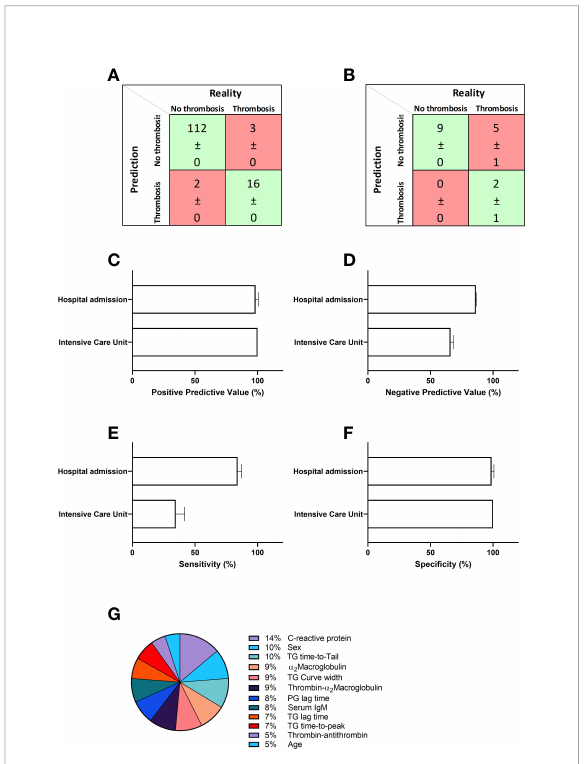
FIGURE 2 Prediction of thrombosis in hospitalized COVID-19 patients. A neural network was constructed to predict thrombosis based on the input parameters described in table 2 in the fi rst patient cohort. (A) The confusion matrix shows that on average 112 out of 114 non- thrombosis patients were correctly predicted and 16 out of 19 were correctly predicted to suffer from thrombosis due to COVID-19. (B) Further validation of the network in a second and separate cohort of COVID-19 patients shows the accurate prediction of 9 out of 9 non-thrombosis patients and 2 out of 7 thrombosis patients. (C) The positive predictive value (PPV) was 98% for the hospital admission cohort and 100% for the ICU cohort. (D) The negative predictive value (NPV) was 86% for the hospital admission cohort and 66% for the ICU cohort. (E) The sensitivity was 84% for the hospital admission cohort, and 34% for the ICU cohort. (F) The speci fi city was 99% and 100%, respectively for the hospital admission and ICU cohorts. (G) The relative importance for each input variable for the accuracy of the outcome of the neural network. Data are represented as mean ± standard deviation of 10 neural net development runs in the confusion matrices in panel A and B, and in the bar charts in (C, D)